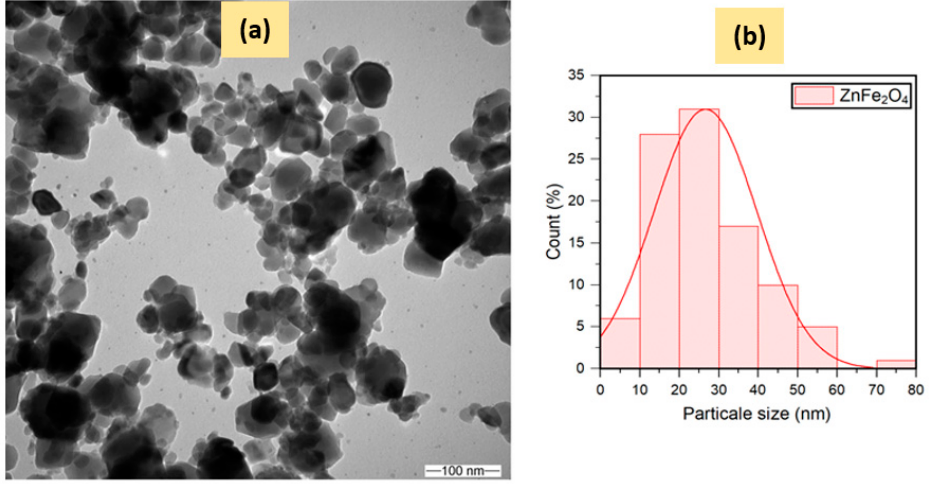
Figure 3. ( a ) TEM micrograph of ZFNPs and ( b ) particle size distribution.